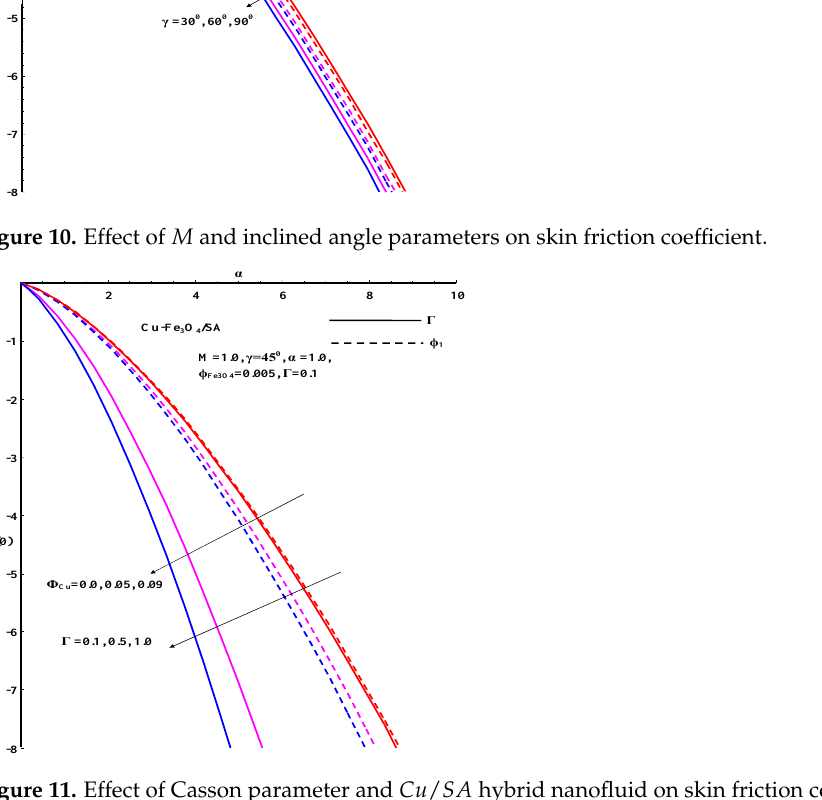
Figure 11. Effect of Casson parameter and Cu / SA hybrid nanofluid on skin friction coefficient.